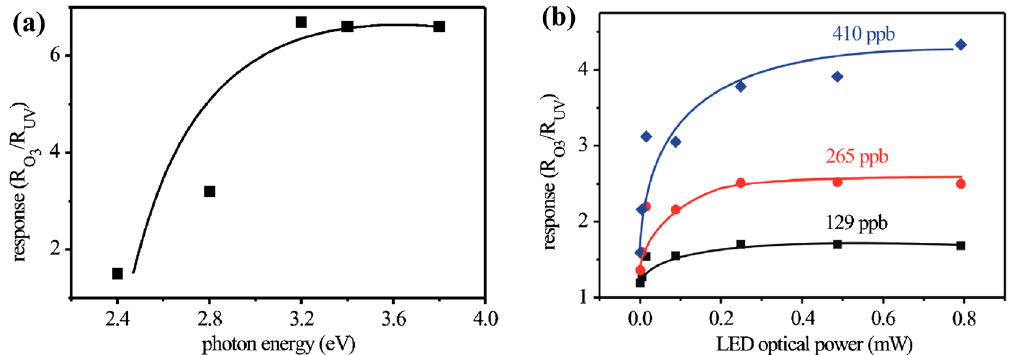
Figure 20. O 3 sensing response vs. ( a ) photon energy; ( b ) LED light power. Reproduced with